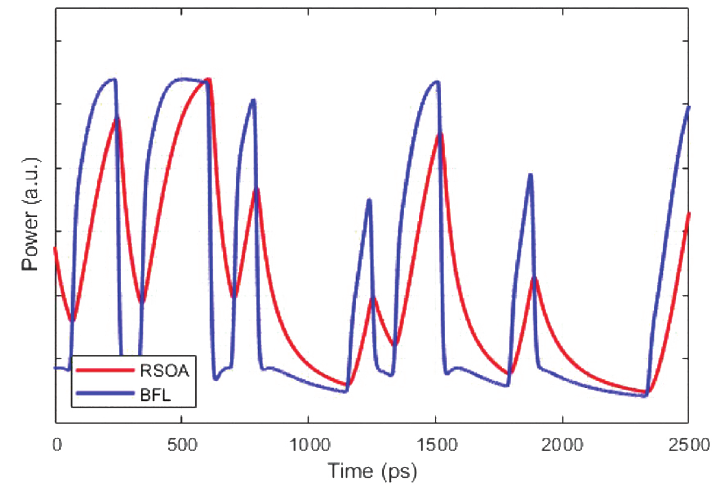
Figure 9. Encoded signal waveforms at RSOA output and BFL output at 11 Gb/s.